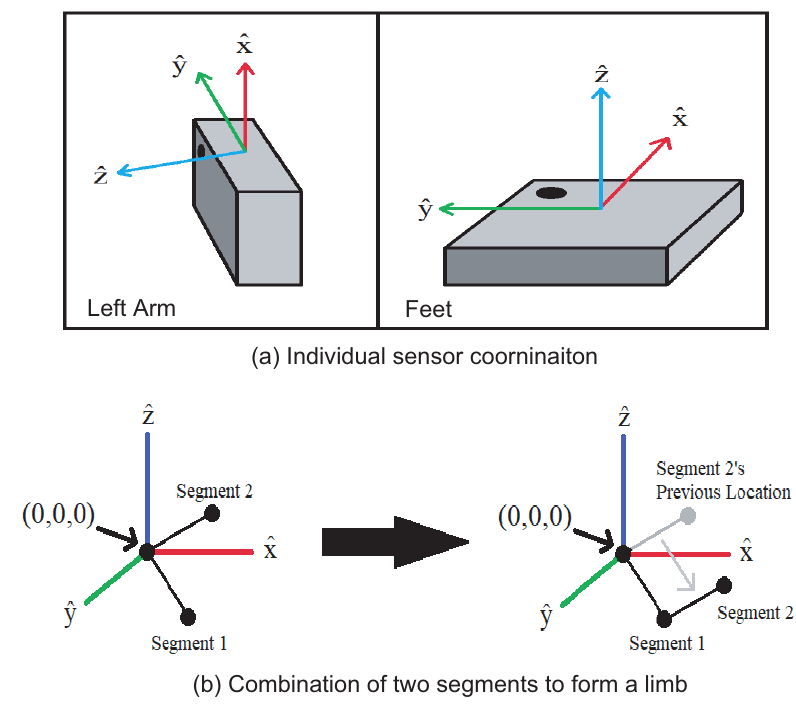
Figure 4. Sensor coordinate and segment combination for limb construction in the 3D human